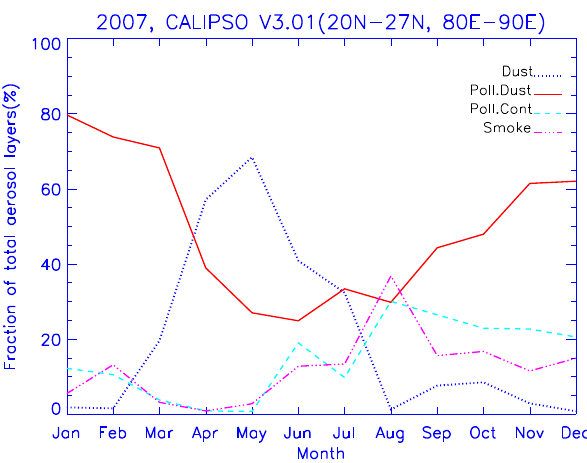
Fig. 8. Seasonal variation of the major aerosol subtypes over East- ern IGP as a fraction of the total number of aerosol layers. All night time aerosol layers with CAD scores of -100 and having layer tops less than 6km above ground were used.